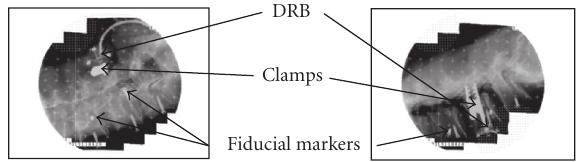
Figure 6: Two C-arm images with fiducial markers and the dynamic reference base (DRB). A superimposed grid of crosses was used to unwarp the images in a calibration